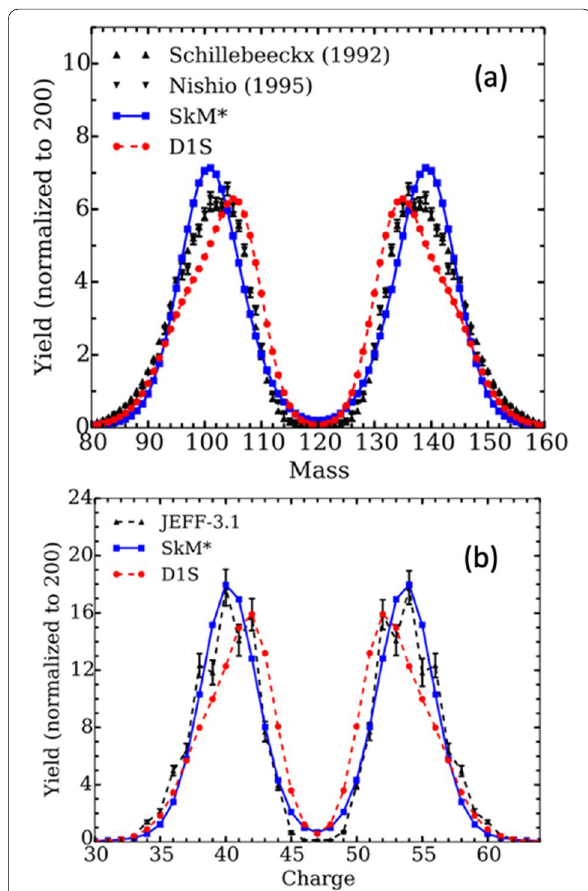
Fig. 12 Fission fragment mass ( a ) and charge ( b ) distributions for the thermal fission of 239 Pu. Calculations are done with the TDGCM formalism for SkM* and D1S EDFs. Mass distribution data are taken from [94, 95] and JEFF-3.1 represents European evaluation. The figure is adapted from